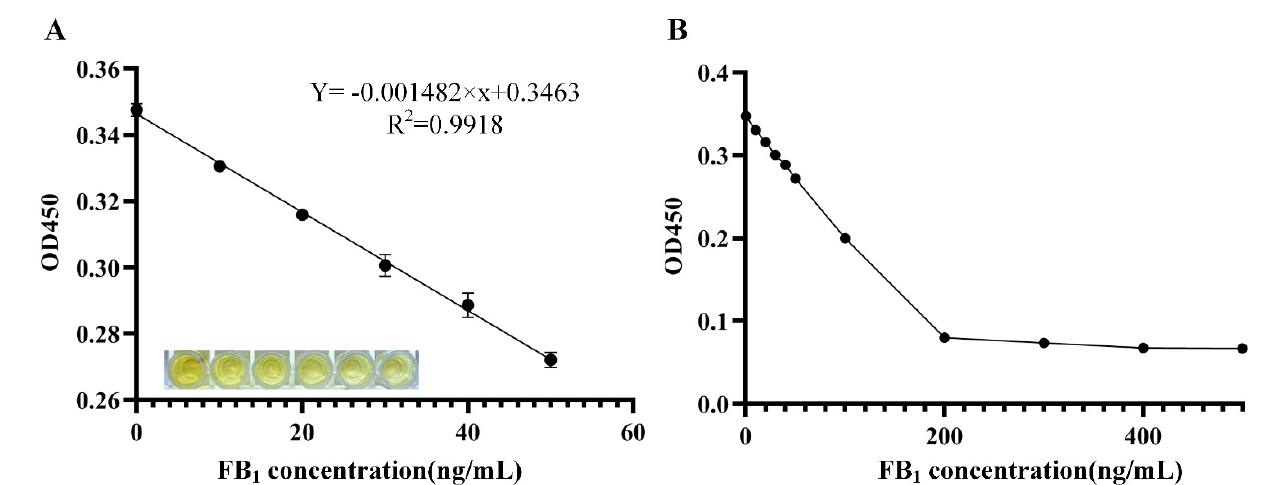
Figure 5. Sensitivity of ELONA for FB 1 detection and detection range. ( A ) Standard curve of FB 1 as detected by ELONA. ( B ) The concentration range of FB 1 can be detected by ELONA.